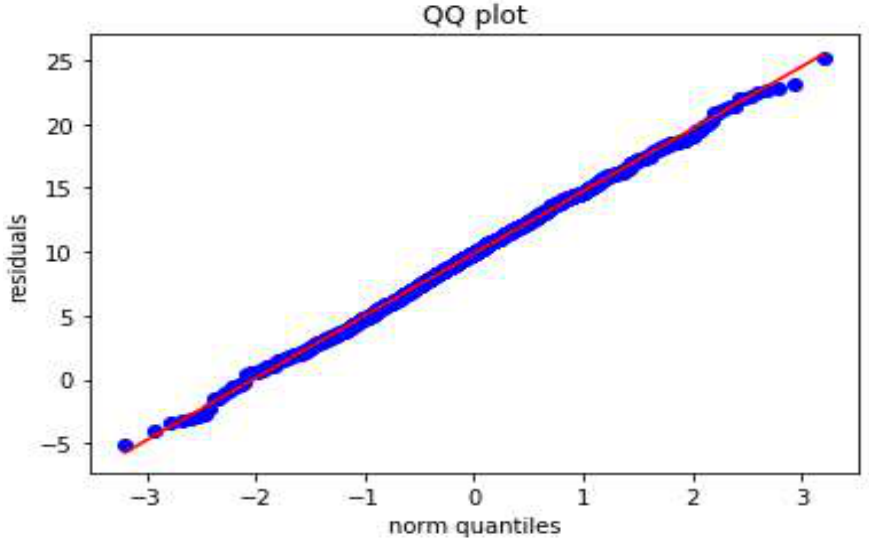
Figure 13. QQ plot (red line showing 45 degrees) shows data variability along the normal quantile distribution.